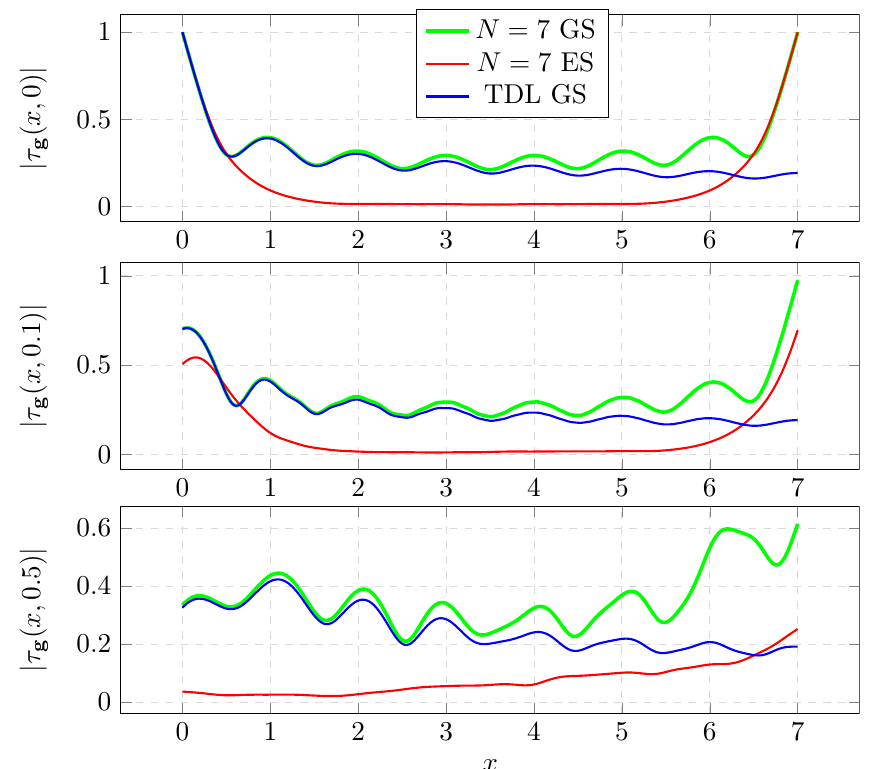
( x , t ) | plotted in space for various g = 2 π n . The TDL indicates the a a L